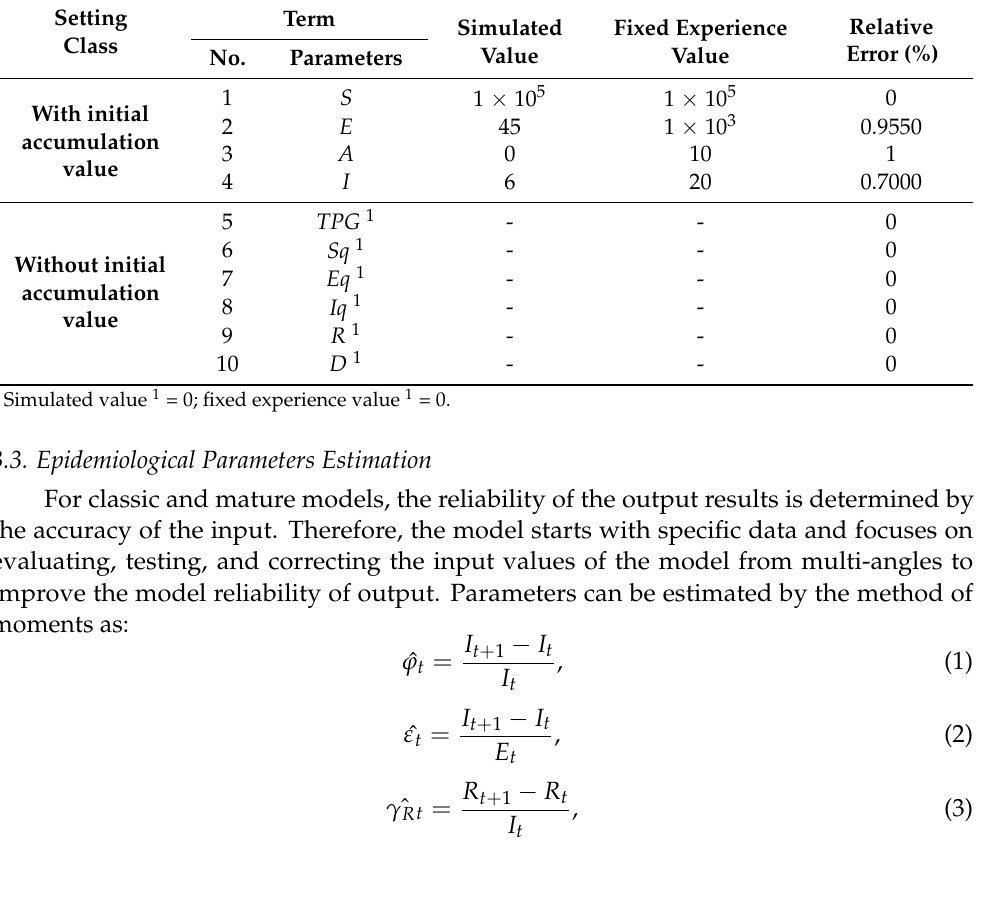
Table 3. The State Parameter of Model. Parameters